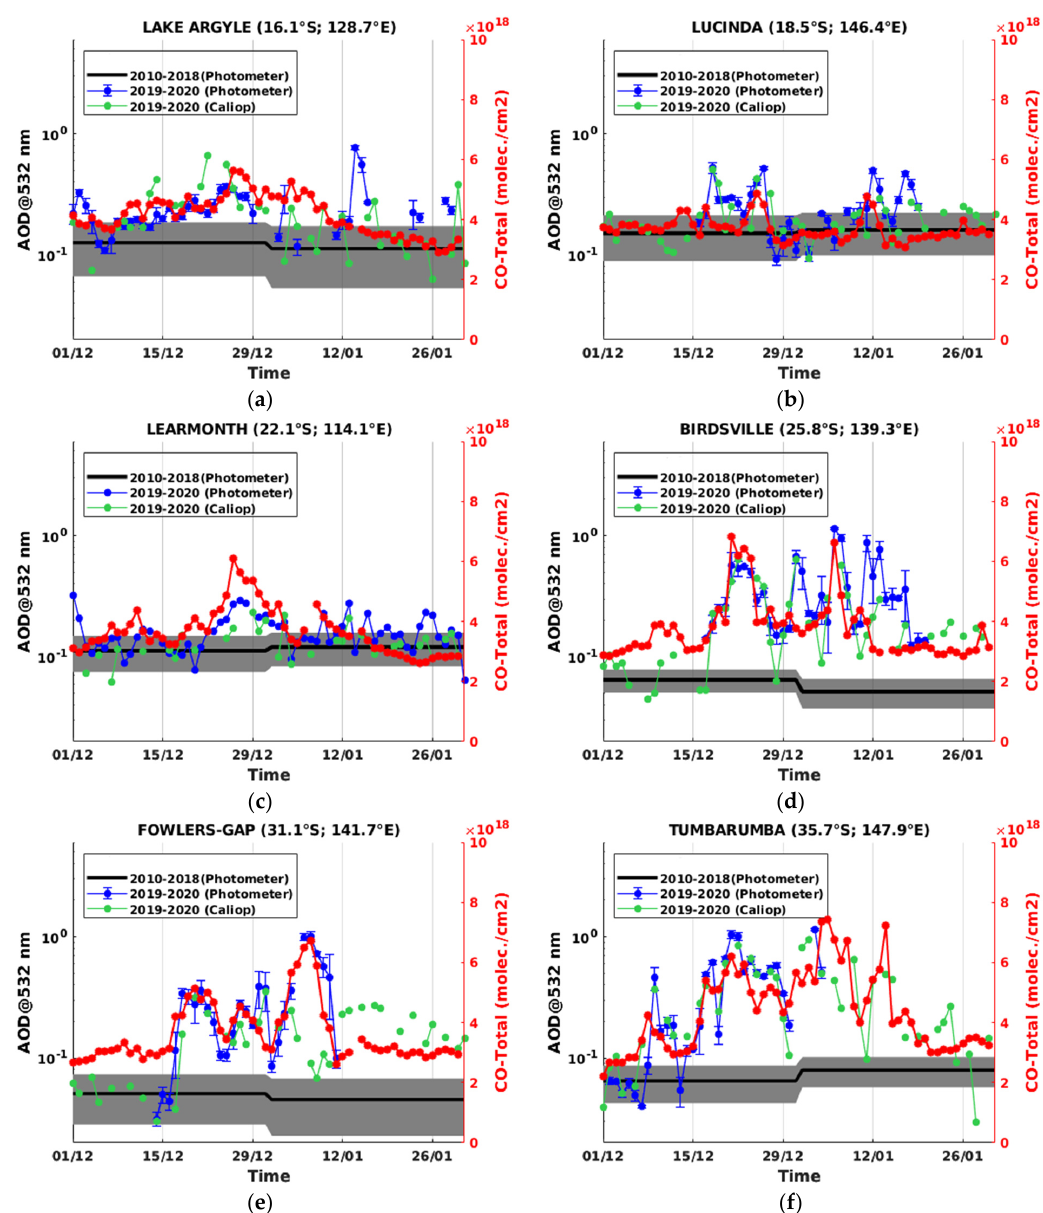
Figure 3. Daily mean of AOD (532 nm) obtained from sun-photometer (blue dots) and CALIOP (green dots, collected over an area of 5° × 5° latitude × longitude centered on each site) observations over the ( a ) Lake Argyle, ( b ) Lucinda, ( c ) Learmonth, ( d ) Birdsville, ( e ) Fowlers Gap and ( f ) Tumbarumba sites from 1 December 2019 to 31 January 2020. The AOD monthly mean and the associated standard deviation calculated during the 2010–2018 period are in black line and grey area, respectively. The red line corresponds to daily mean of total column of CO from IASI.